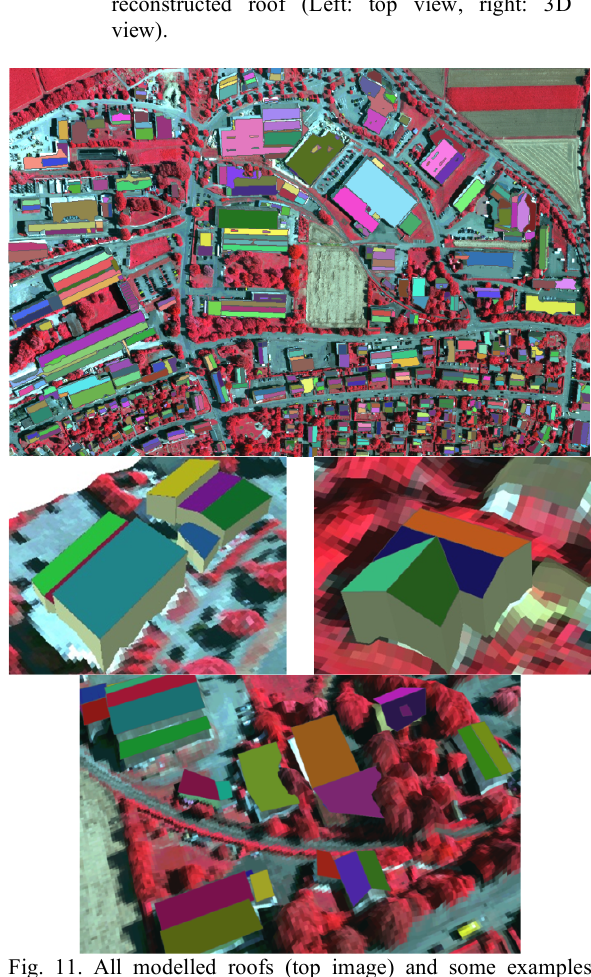
Fig. 11. All modelled roofs (top image) and some examples from modeled roofs with different colours for each individual roof